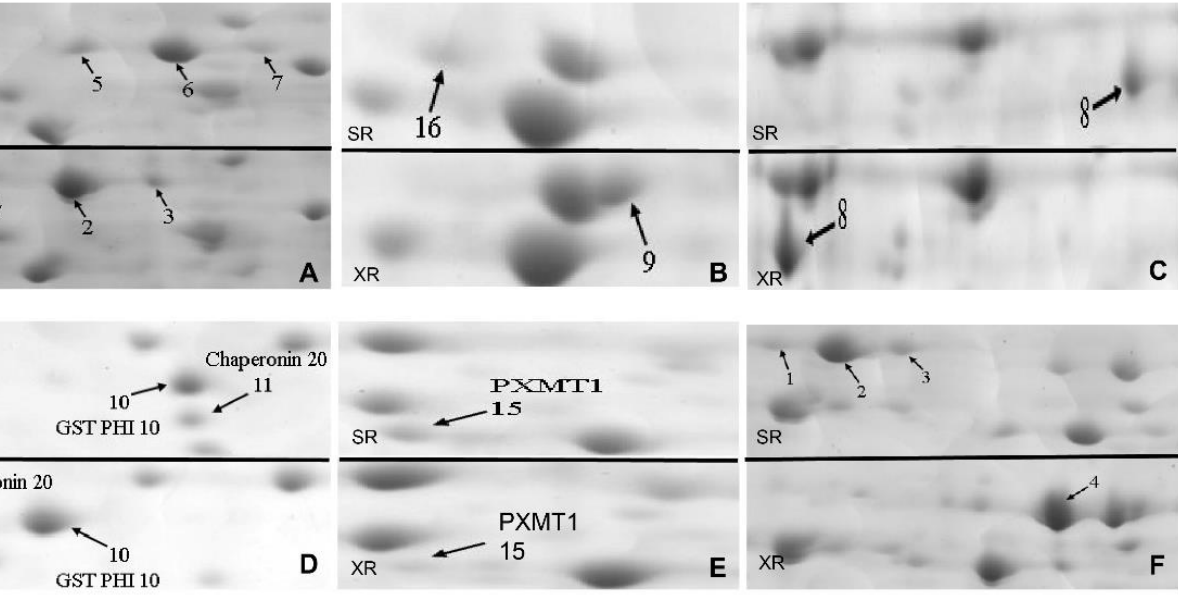
Figure 6. Expression patterns of some root protein spots on the 2-DE map. Marked points are differentially expressed proteins. ( A ) 2,3-bisphosphoglycerate-independent phosphoglycerate mutase 1 (iPGAM1) (spots SR5, 6 and 7, spots XR7, 2 and 3). ( B ) pyruvate dehydrogenase E1 component subunit beta-1 (MAB1) (spots SR16, XR9). ( C ) monodehydroascorbate reductase 2 (MDAR2) (spots SR8, XR8). ( D ) glutathione S-transferase F10 (GST PHI10) (spots SR10, XR10) and 20 kDa chaperonin (Chaperonin 20, Cpn20) (spots SR11, XR11). ( E ) paraxanthine methyltransferase 1 (PXMT1) (spots SR15, XR15) and ( F ) jacalin-related lectin 34 protein (JRL34) (spots SR1, 2, 3, and spots XR4). The abbreviations for Figure 6 were: SR, root of SD ecotype; XR, root of XJ ecotype. In addition to metabolism-related proteins, oxidation-reduction process-related pro- teins were increased or present only in XJ ecotype roots, including NADH dehydrogenase [ubiquinone] iron-sulfur protein 1 (CI76) (spot XR1, Table 2), NAD(P)H dehydrogenase (quinone) (FQR1) (spot XR13, Table 2), monodehydroascorbate reductase 2 (MDAR2) (spots SR8, XR8, Figure 6C). In particular, methylmalonate-semialdehyde dehydrogenase (MMSDH) (spot XR6, Table 2) was highly expressed in XJ Eutrema roots but not in the SD ecotypes. CI76 encodes the subunit of the 400 kDa subcomplex of the mitochondrial NADH dehydrogenase (complex I), the first complex of the respiratory chain and the main entrance site for electrons into the respiratory electron transfer chain, and plays a role in maintaining redox balance in plant cells [38]. FQR1 belongs to the family of flavin mononucleotide-binding quinone reductases, catalyzes the electron transfer of NADH and NADPH to multiple substrates, and functions as a quinone reductase in plants. Its gene, FQR1, is the main gene of the auxin response. Hence, it is speculated that FQR1 might be involved as a detoxification enzyme in the auxin-induced redox process [39]. As a key component of the ascorbate-glutathione cycle, MDAR2 plays a role in scavenging toxic reactive oxygen species, such as H 2 O 2 , a byproduct of aerobic metabolism in plant chloro- plasts, mitochondria, and peroxisomes [40]. Aldehyde dehydrogenases (ALDHs) represent a protein superfamily of NAD(P) + -dependent enzymes that oxidize various endogenous and exogenous aliphatic and aromatic aldehydes to the corresponding carboxylic acids. ALDHs play an important role in regulating aldehyde homeostasis, and